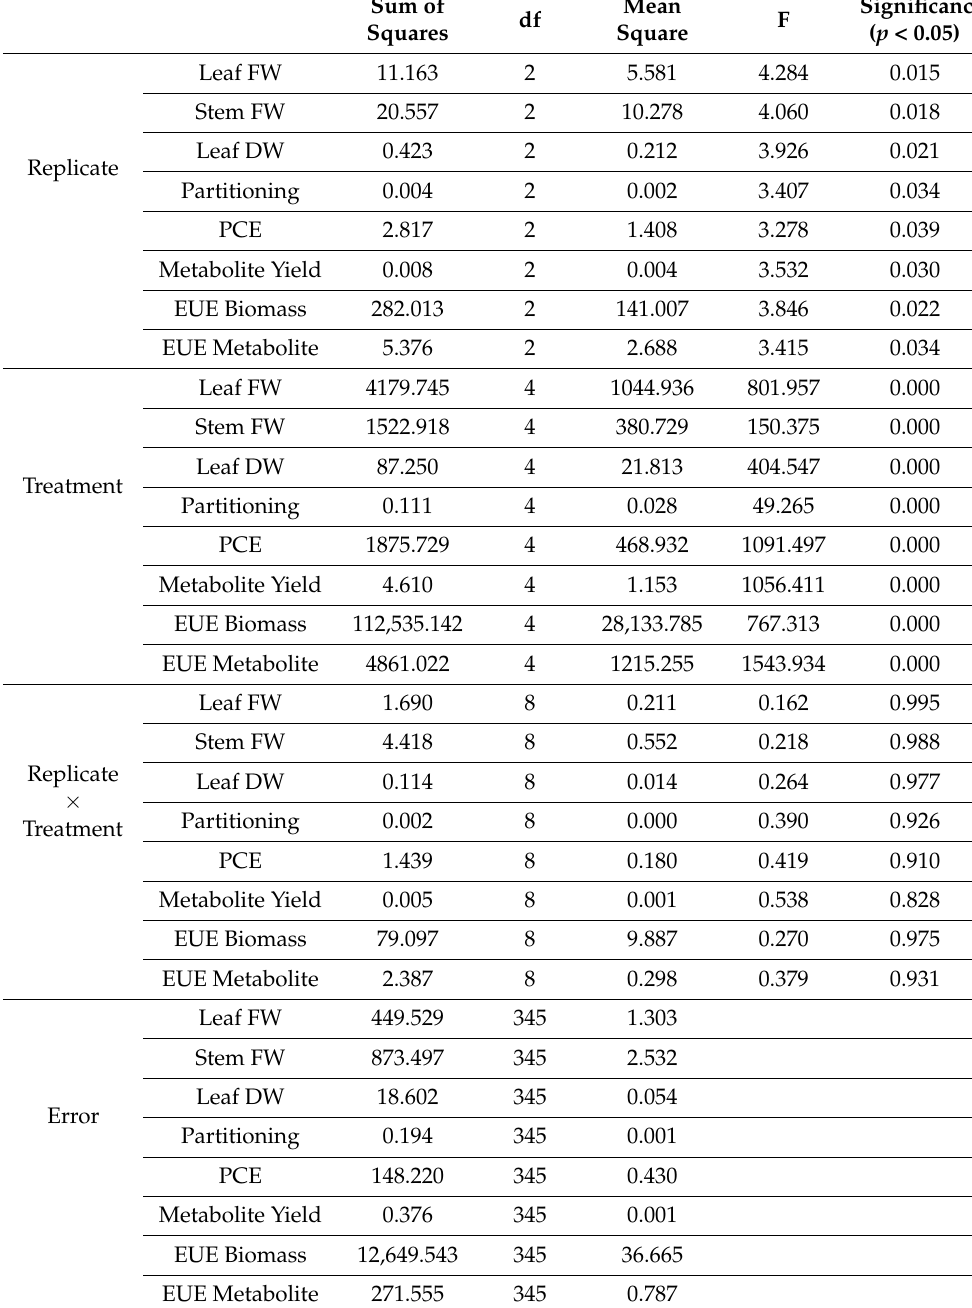
Table 3. ANOVA results on interaction